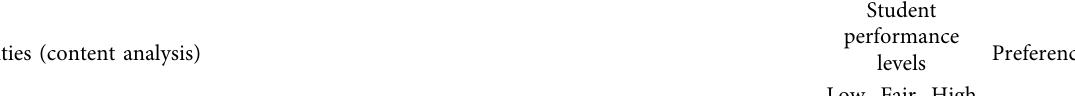
Table 5: Number of students at different performance levels and learning preferences.